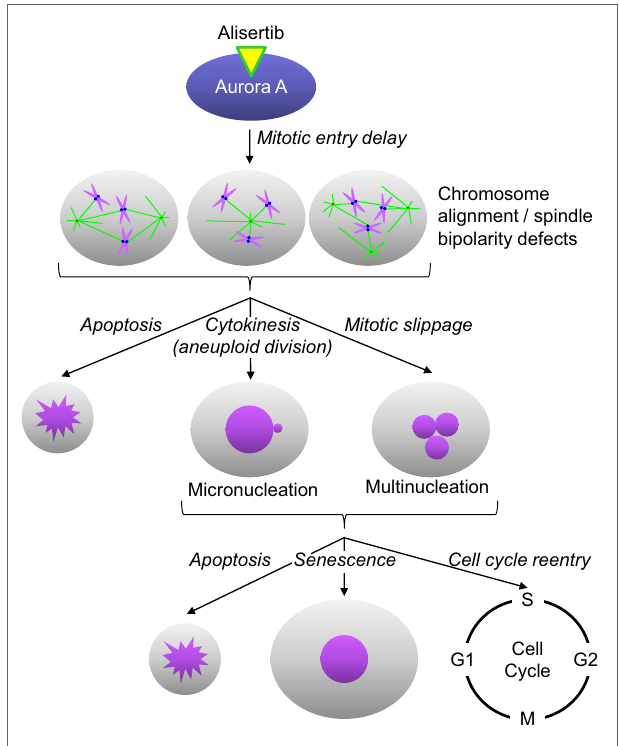
FiGURe 1 | Alisertib mechanism of action . Alisertib selectively binds to and inhibits Aurora A kinase in cells. Inhibition of Aurora A results in delayed mitotic entry and progression through mitosis leading to an accumulation of cells with a tetraploid DNA content. Mitotic cells treated with alisertib display a variety of defects, including monopolar, bipolar, and multipolar spindles, all with misaligned chromosomes. These cells can die directly out of mitosis via apoptosis, undergo aneuploid cytokinesis or exit mitosis without undergoing cytokenesis through a process known as mitotic slippage. The resulting interphase cells typically display gross nuclear defects including micronucleation and multinucleation. These cells will then undergo apoptosis, senescence or reenter the cell cycle; the specific fate is likely dictated by the extent of DNA damage/aneuploidy that occurred in any cells as a result of the abnormal mitotic division as well as other underlying genetic